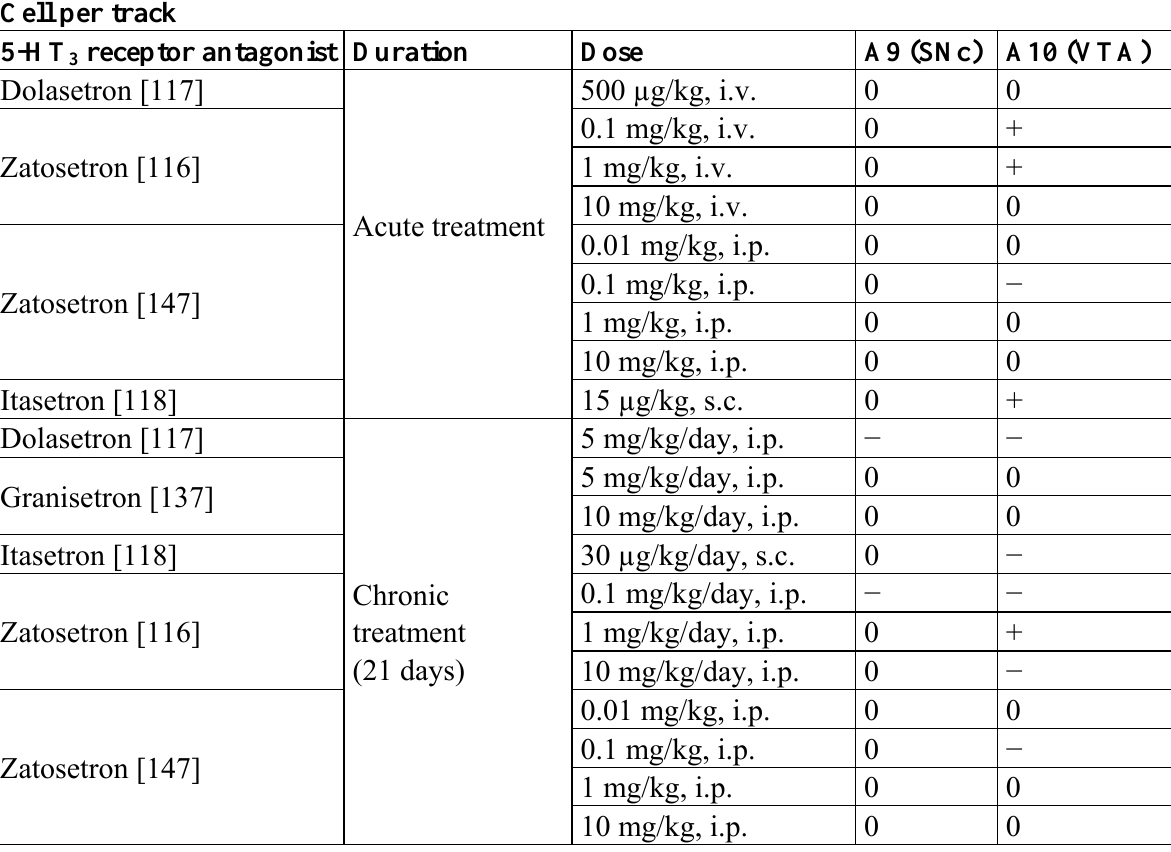
Table 2. Acute and chronic effects of 5-HT cell/track. 5-HT3 receptor antagonists had either no effect (0) either an increase (+) or a decrease ( − ) on the number of